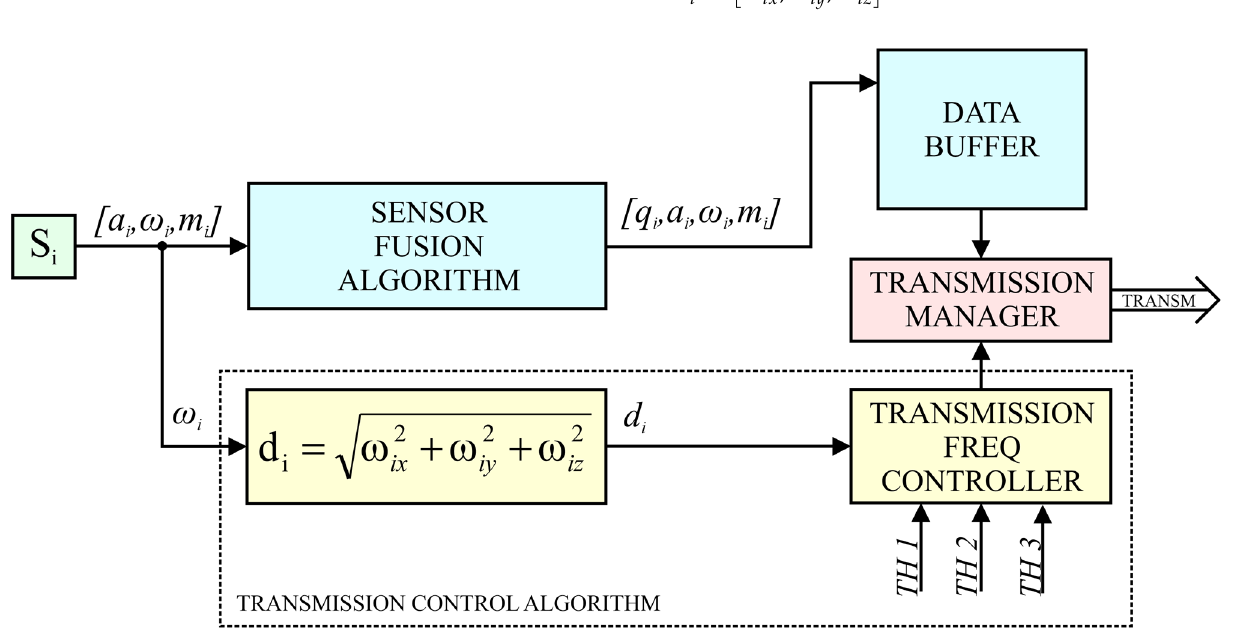
Figure 6. Logical diagram of WSS operation.